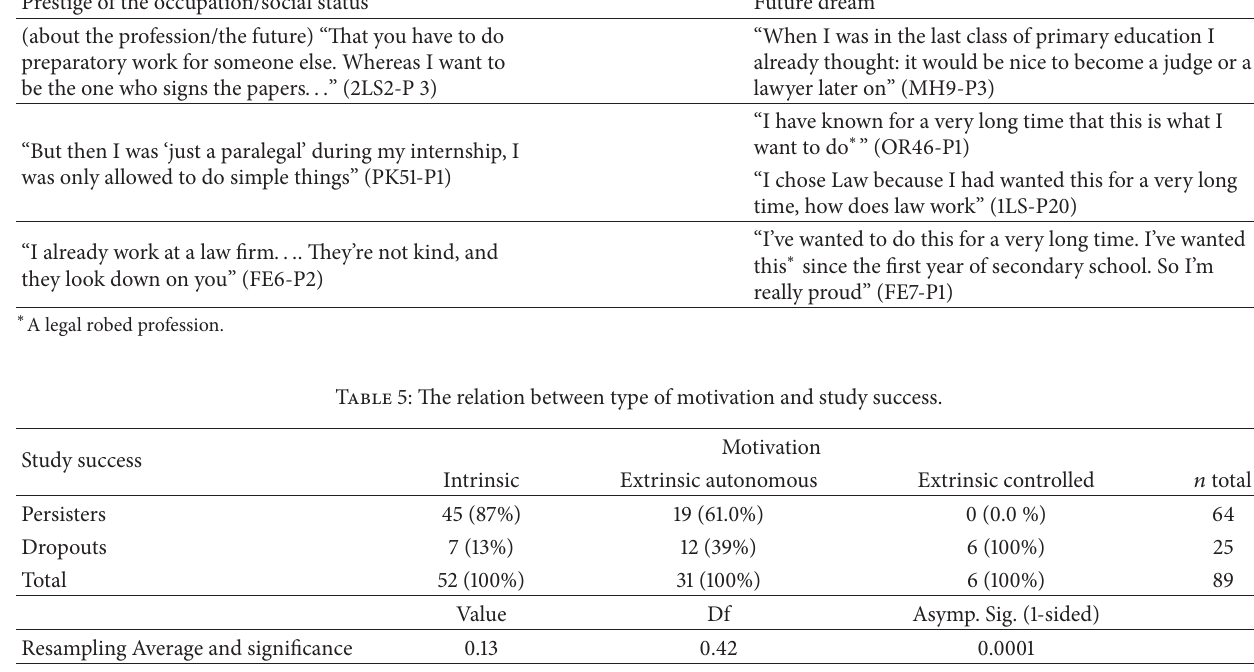
Table 4: Examples of quotes expressing the intention to switch to the university, with references to the status and to long existing dreams. Prestige of the occupation/social status